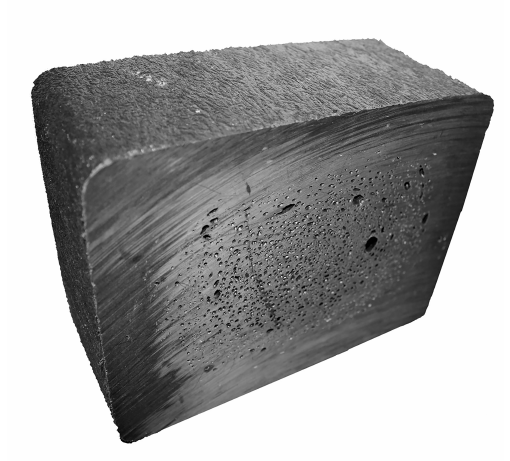
Figure 1. Example of a